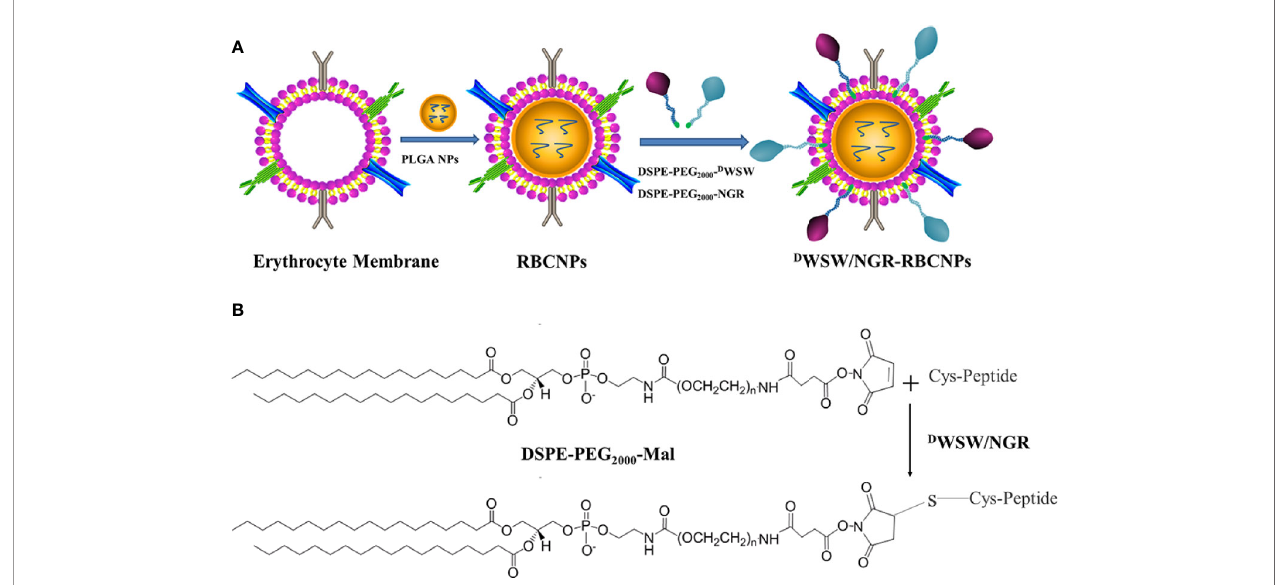
FIGURE 2 | Preparation of D WSW/NGR-RBCNPs. First, the drug was loaded into PLGA, coated with erythrocyte membrane, and fi nally target-modi fi ed (A) . The targeting ligand was then synthesized by conjugating DSPE-PEG 2000 -Mal to the cysteine residue on both D WSW and NGR (B) . The Michael addition reaction was used in chemical